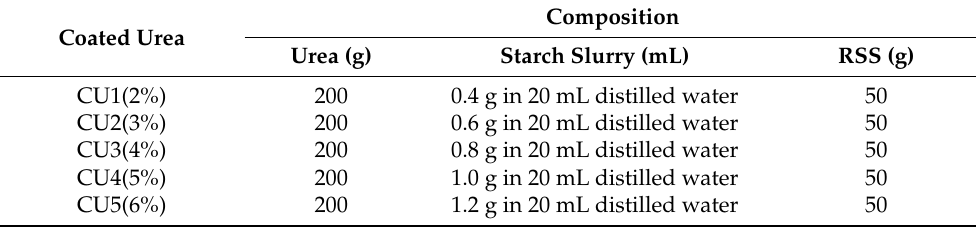
Table 1. Composition of rejected sago starch formulations for urea coating.